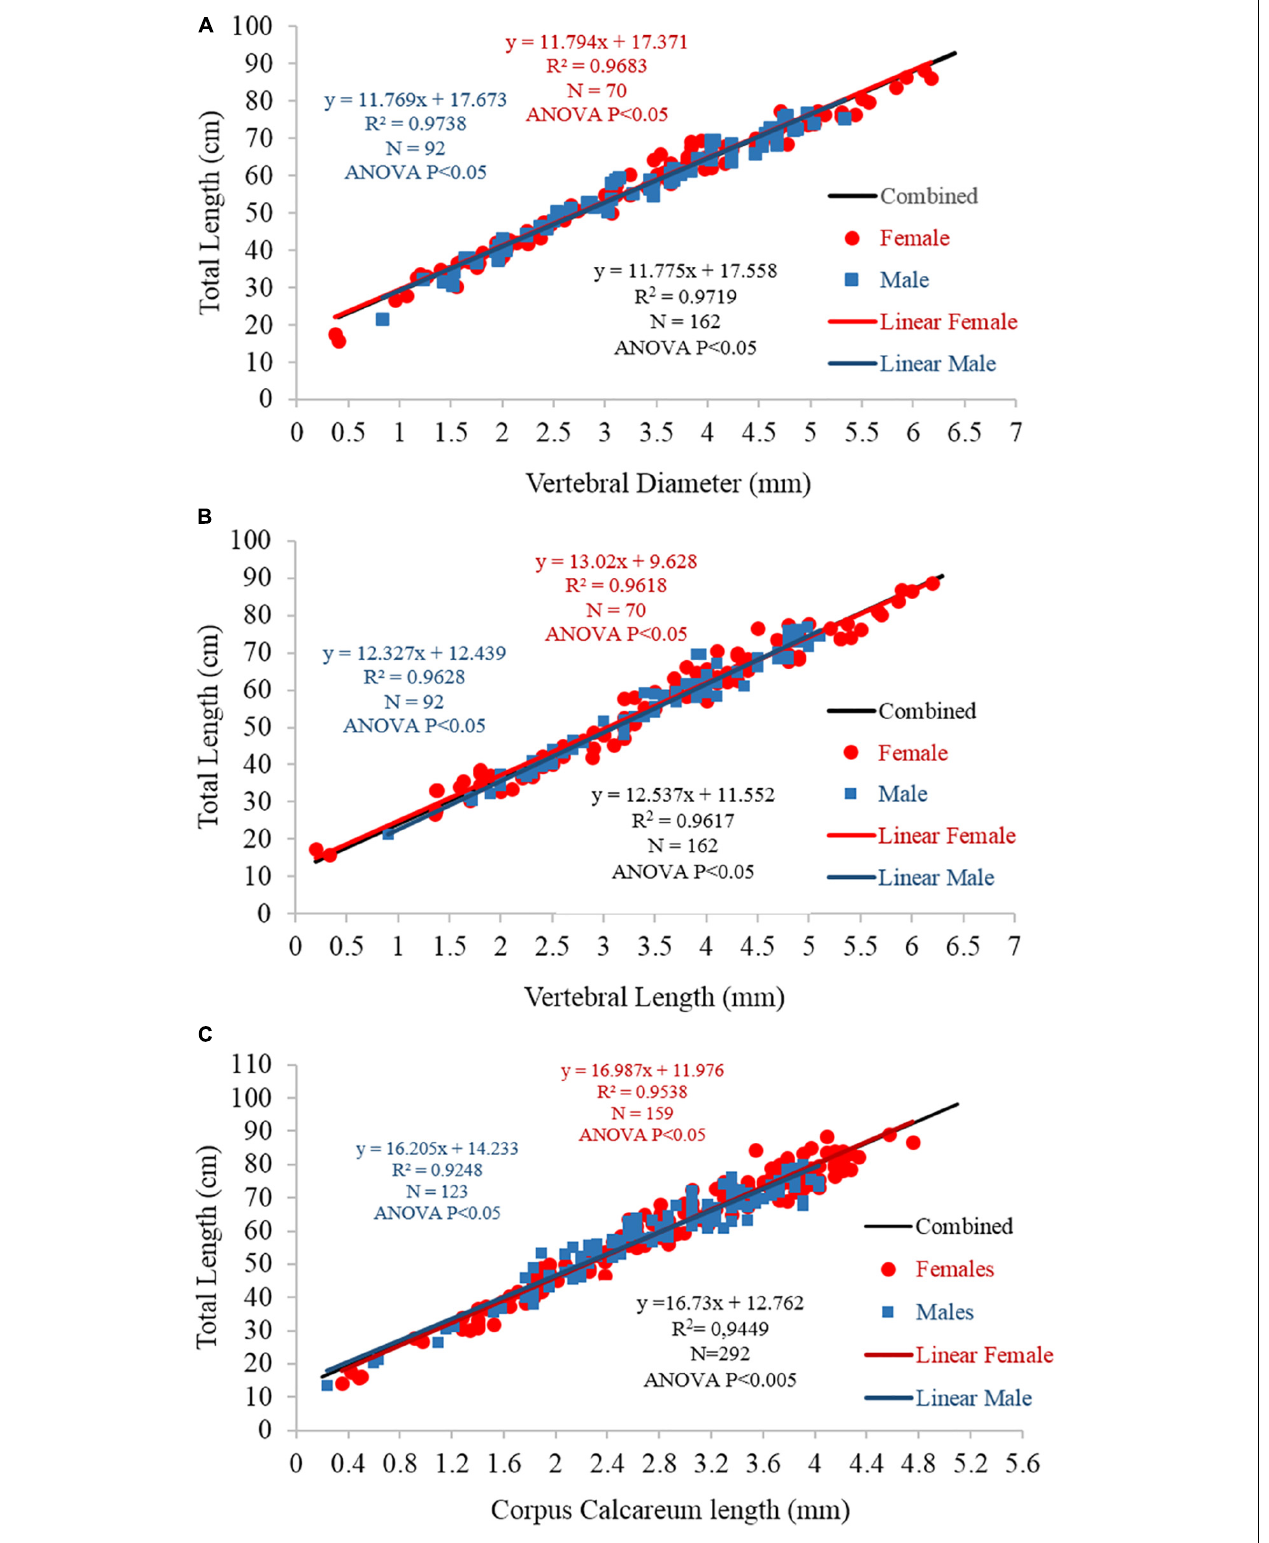
FIGURE 8 | Linear regression between fish total length and (A) vertebral diameter, (B) vertebral length, and (C) corpus calcareum length for females (blue), males (red), and the sexes combined (black). The equations, R 2 -values, numbers of specimens, and statistical significance results are also reported.